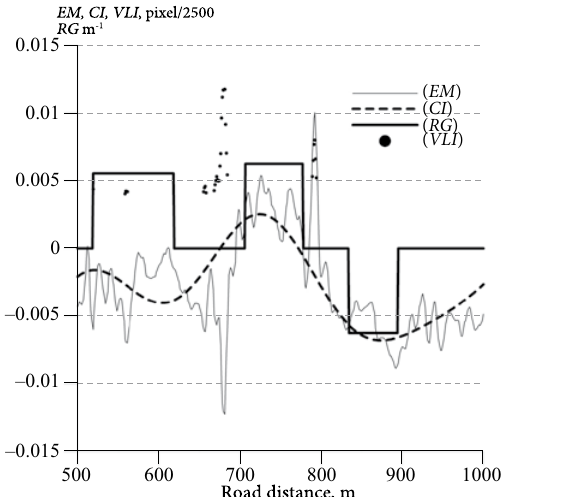
Fig. 7. Relationship between CI function of the sample and EM and VLI for a specific driver (the data concern the road distance from 500 to 1000 m )